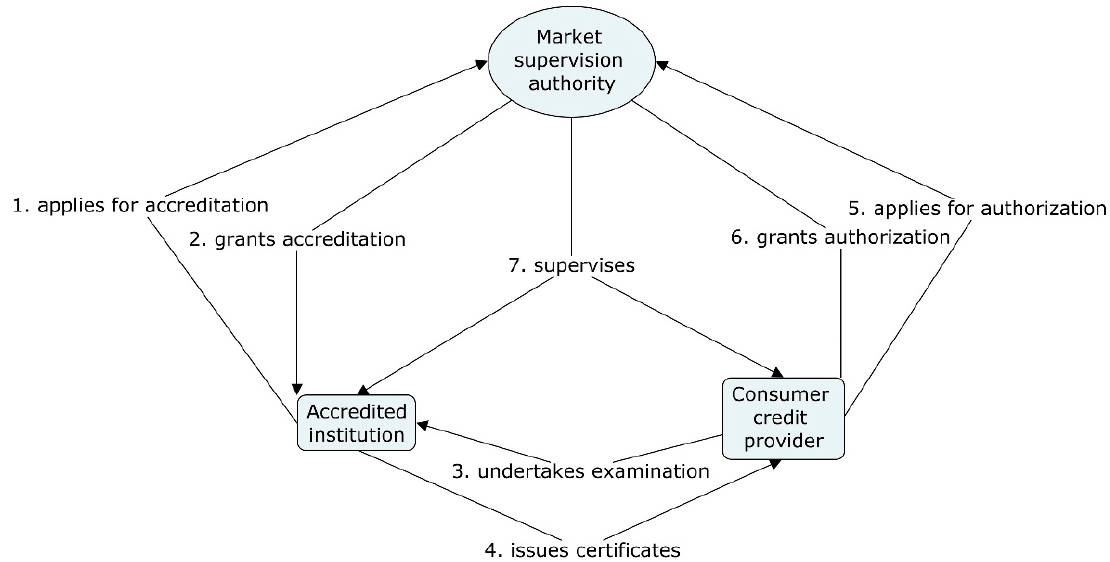
Figure 5. Simplified professional qualifications examination scheme in the case of a new consumer credit provider.